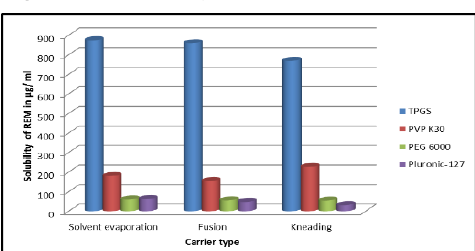
Figure 3. Effect of carrier type of REM solid dispersion at a ratio (1:12) on the solubility of REM in distilled water at 25°c (results are expressed as mean, n=3).